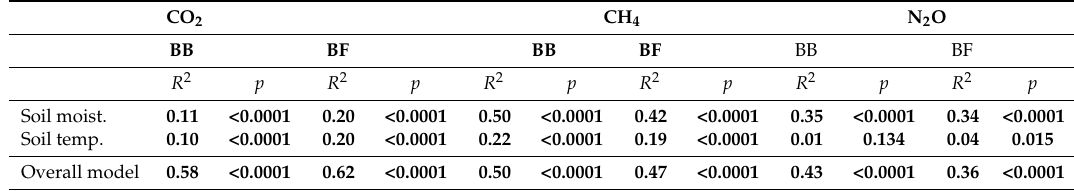
Table 3. The regression analyses to disentangle the relationships between soil temperature/moisture and soil-atmosphere GHG fluxes: The table shows both regressions for the two single factors (as illustrated in Figure 4) as well as multiple regression models to illustrate the combined explanatory power of moisture and temperature ( n = 91 each). The significant effects are shown in bold at p < 0.05. CO 2 CH 4 N 2 O BB BF R 2 p R 2 p Soil